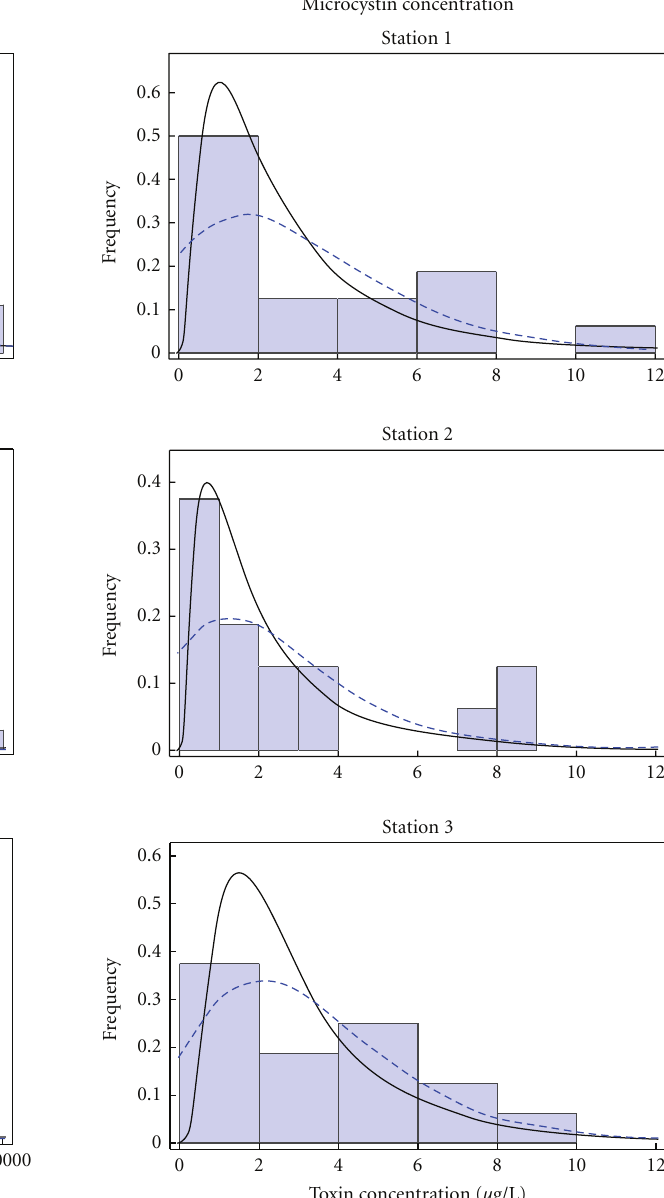
Figure 7: Histograms of M. aeruginosa cell counts in the water at the three sampling sites described by the log-normal (solid line) and extreme value (dashed line) distribution functions.